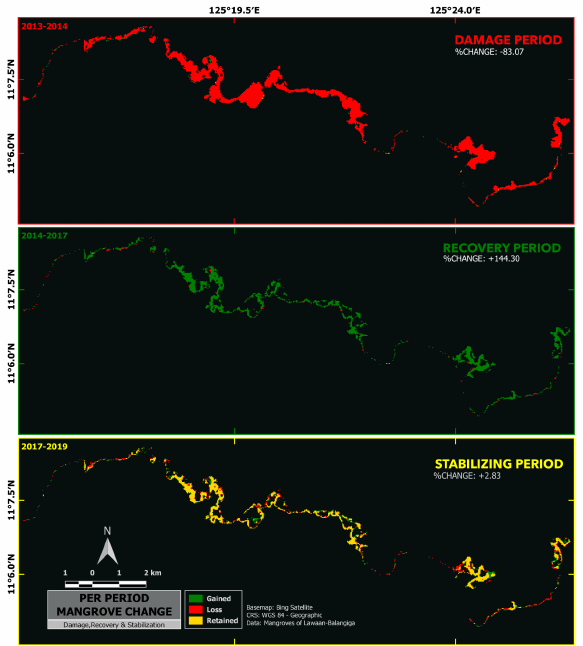
Figure 13. Damaged Period (2013-2014), Recovery Period (2014-2017) & Stabilizing Period (2017-2019) Mangrove Change